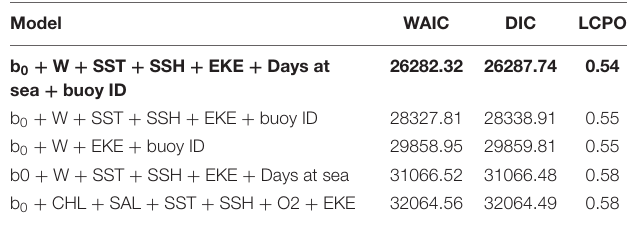
TABLE 2 | Comparison of the most relevant models for the tuna B-HSMs. Model